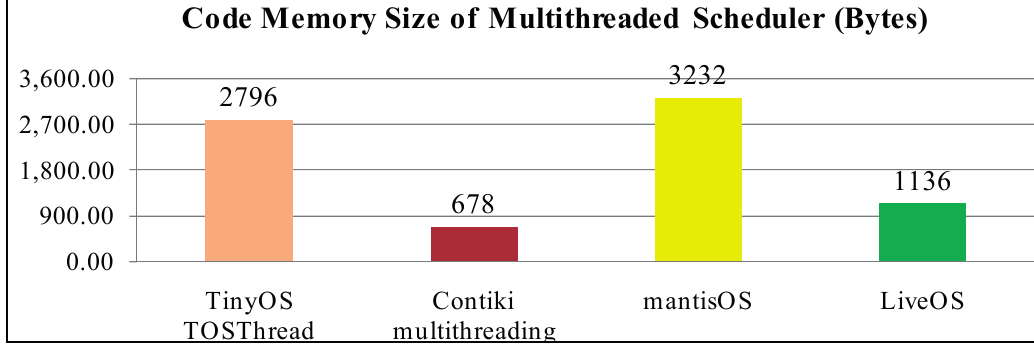
Figure 16. Code memory size of the multithreaded scheduler in different WSN